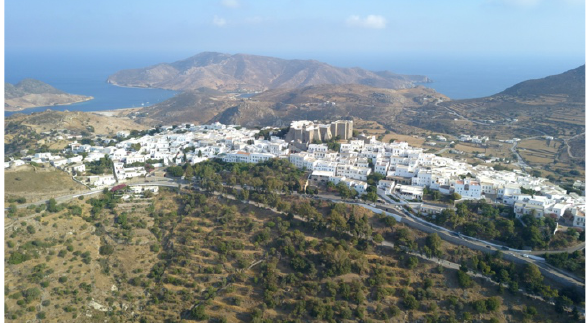
Figure 1. Island of Patmos and view of the